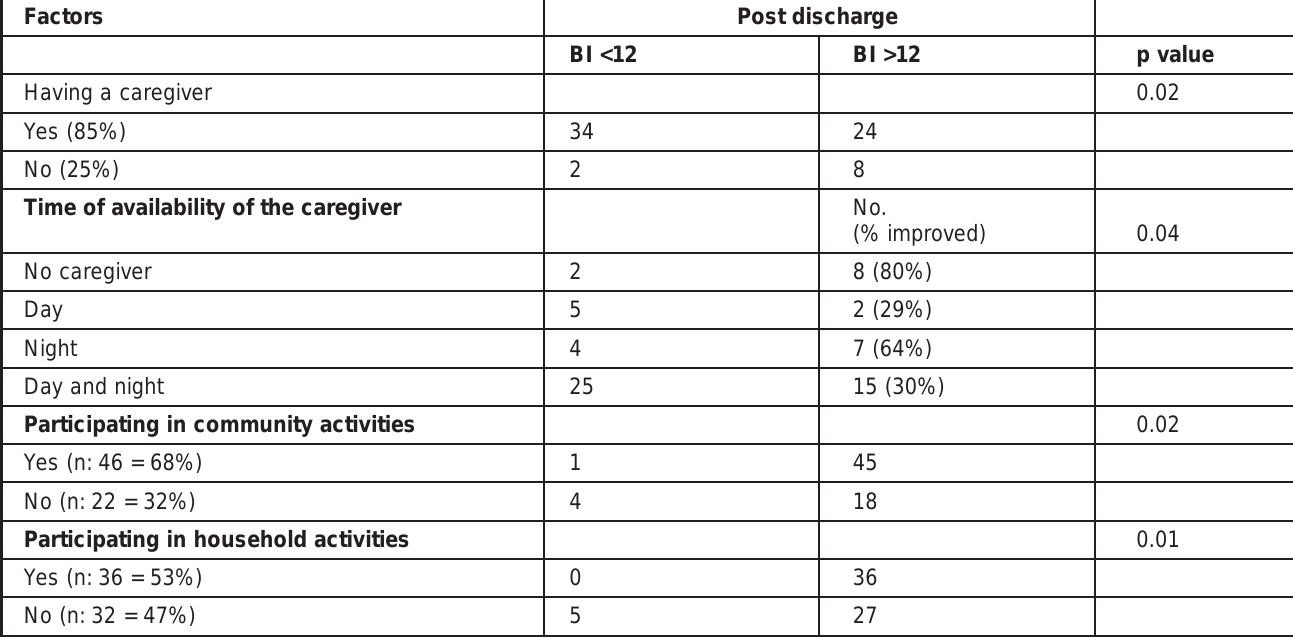
Table 2: Influence of environmental factors on functional independence (n=68)